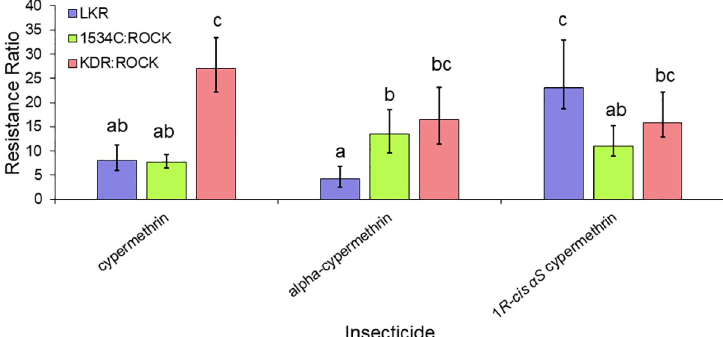
Fig 5. Levels of resistance levels conferred to 1 R-cis α S cypermethrin, alpha-cypermethrin (mix of the 1 R-cis α S and 1 S - cis α R isomers), and cypermethrin (mix of eight isomers) in the LKR, 1534C:ROCK and KDR:ROCK strains having the 410L+1016I+1534C, 1534C and 989P+1016G alleles, respectively. The RR for KDR:ROCK to cypermethrin was previously published [25] and is given here for comparison purposes. Bars with different letters are significantly different based on non-overlap of the 95% confidence intervals.